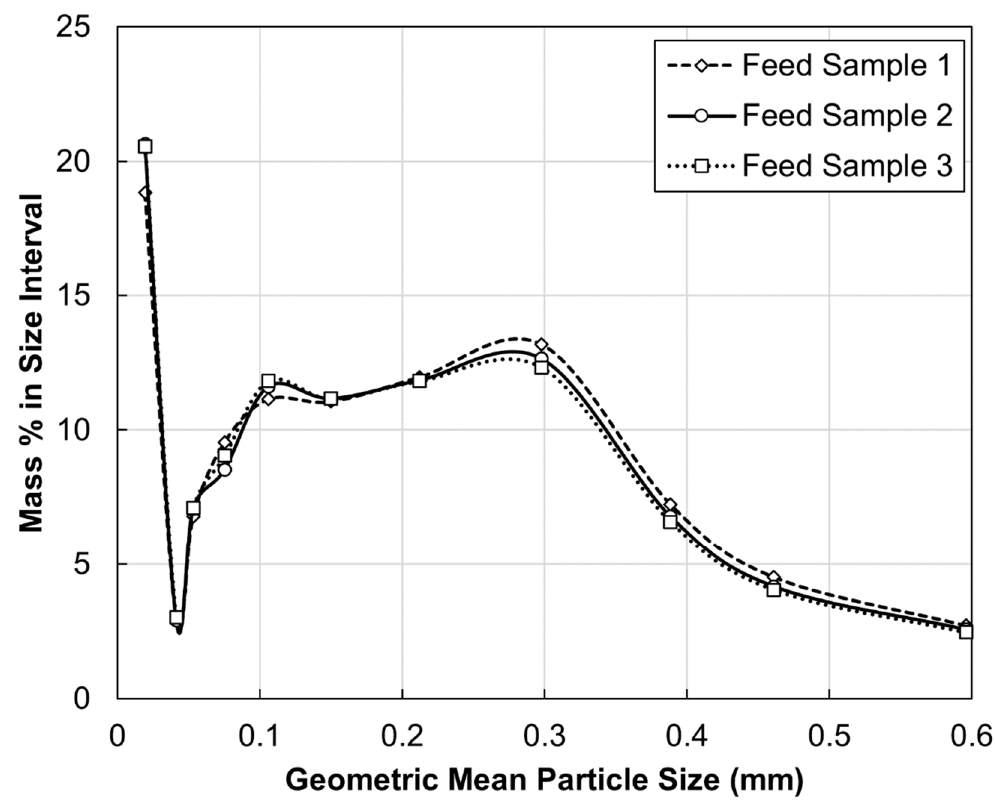
Figure 2. Feed samples taken during one experiment. Feed samples were collected at approximately 90 min, 210 min, and 250 min run time, respectively. The size distributions of the feed samples are almost identical.